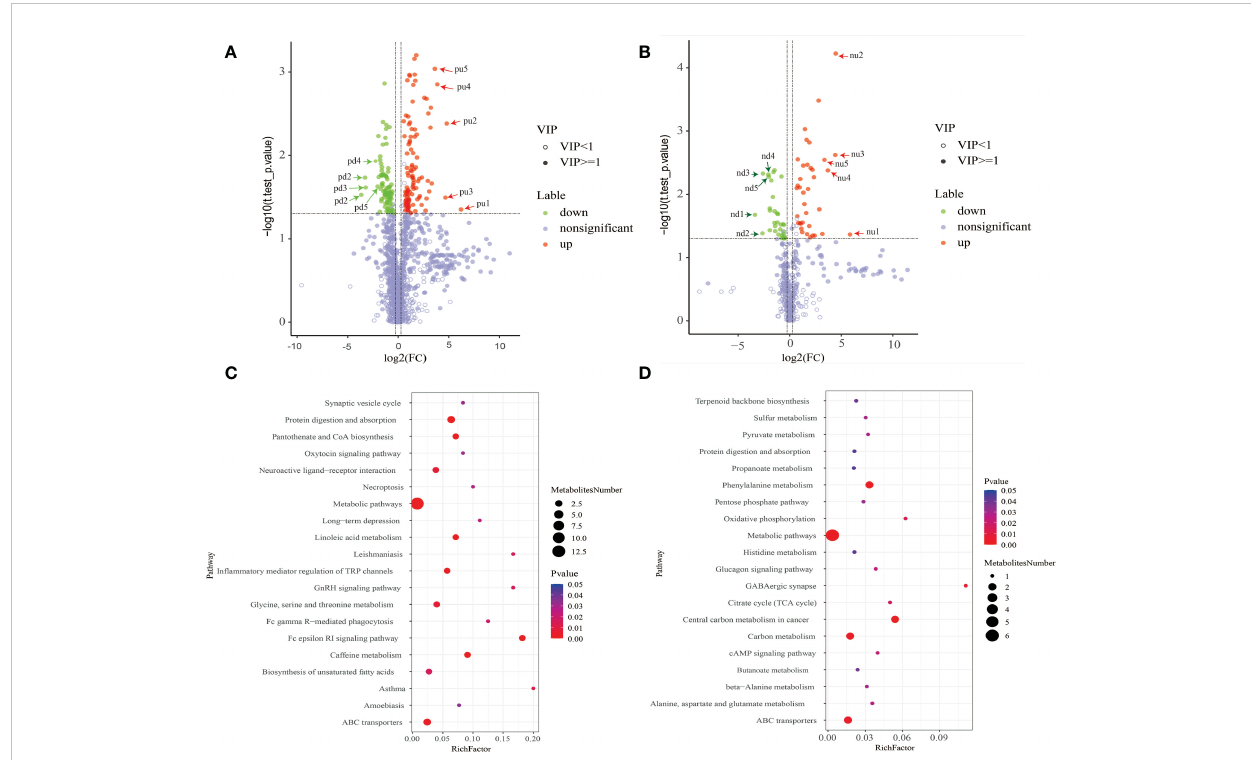
FIGURE 4 (A, C) The positive ion mode; (B, D) the negative ion mode. (A, B) Results from volcano plot analysis.Blue indicates signi fi cantly down-regulated differential metabolites, and red indicated signi fi cantly up-regulated differential metabolites, purple-gray indicates metabolites with no signi fi cant difference. (C, D) Results of metabolic pathway enrichment analysis of differential metabolites. Metabolic pathways with a p-value< 0.05 were signi fi cantly enriched by differential metabolites. The X-axis represents the rich factor, the greater the rich factor, the greater the ratio of different metabolites annotated to this pathway. The dot size represents the number of differential metabolites annotated to this pathway. Enrichment analysis was based on annotated metabolites in KEGG database. The annotation results of differentiated metabolites screened in this project were statistically analyzed by combining hypergeometric test, and the p-value of corresponding pathway was obtained. Then, p-value<0.05 was taken as the threshold to determine whether the pathway was enriched or not. The ggplot2 package in the R package is used for mapping.